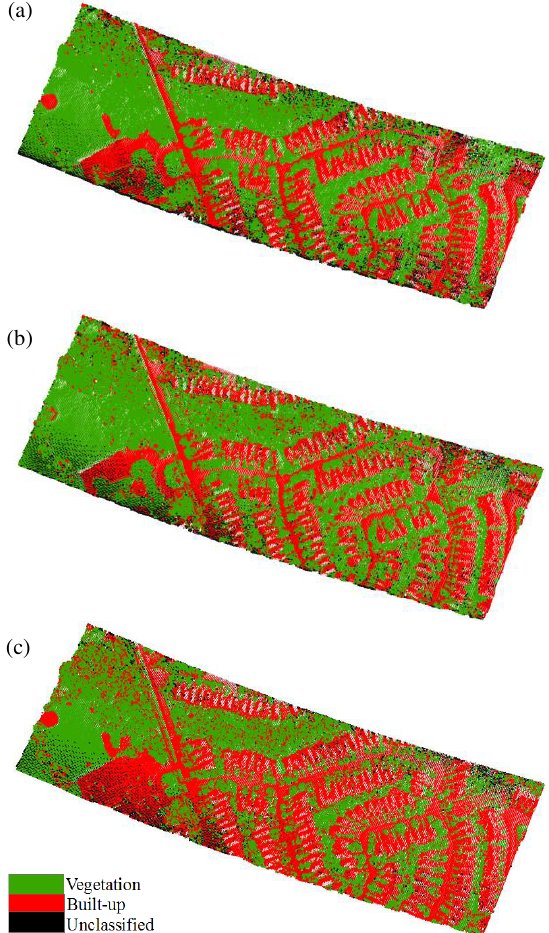
Figure 11. Labelled LiDAR points of Site II from: a) NDFI G-NIR , b) NDFI G-MIR , and c) NDFI NIR-MIR